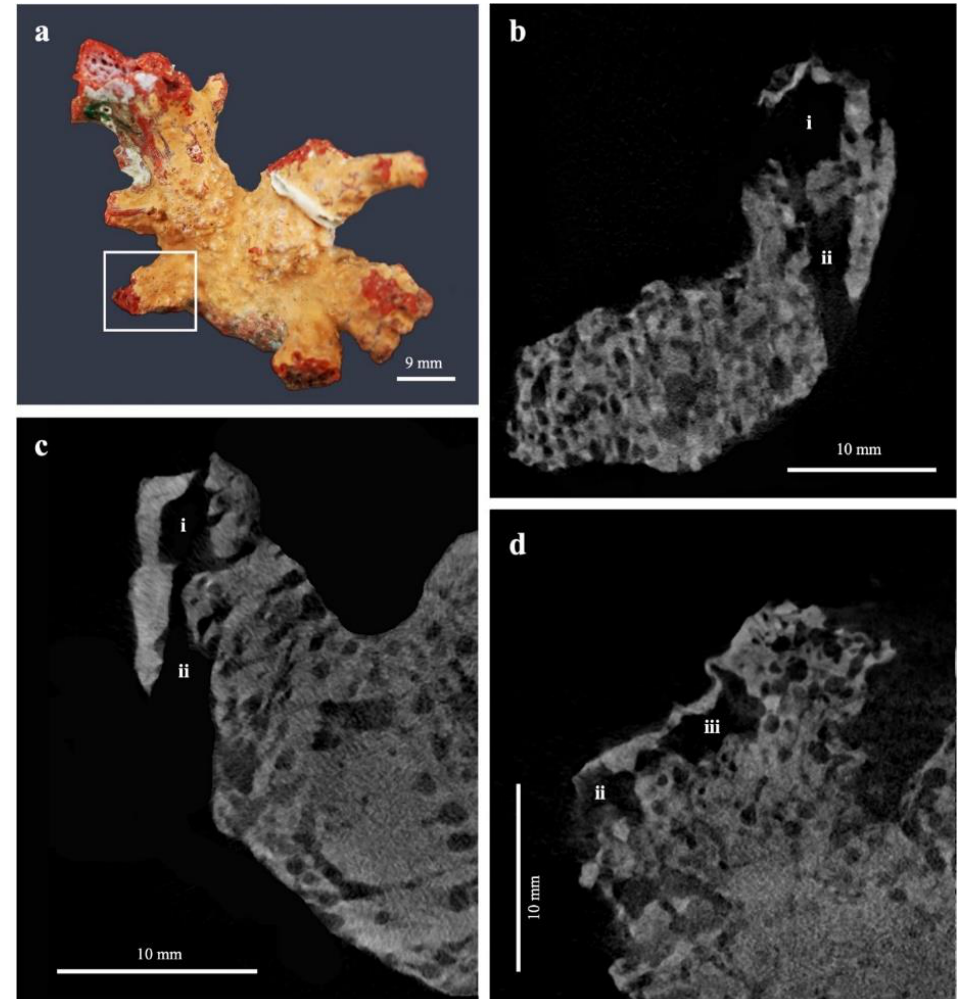
Figure 4. Red coral sample excavated by Alectona ricardi sp. nov. along with cross-sections from micro-CT scans: ( a ) red coral sample CTX; the marked area is the part of the sample where the new species was detected; ( b ) perpendicular (xz) cross-section showing two of the three cameras (i,ii) of A. ricardi sp. nov.; ( c ) perpendicular cross-section (xy) showing the same two cameras (i,ii) with a different perspective; ( d ) transversal cross-section (yz) showing the second and the third cameras (ii,iii) of this species. The camera occupying the more basal part of the ramification (ii) resulted in an opening to the exterior due to secondary erosion.